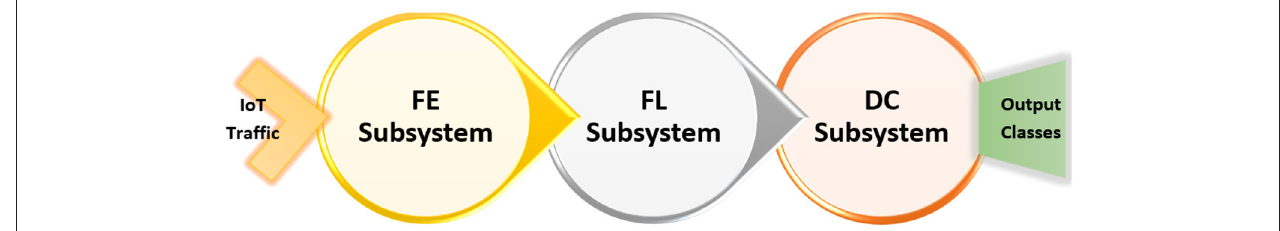
FIGURE 2 | The three main subsystems composing the proposed System of Interest